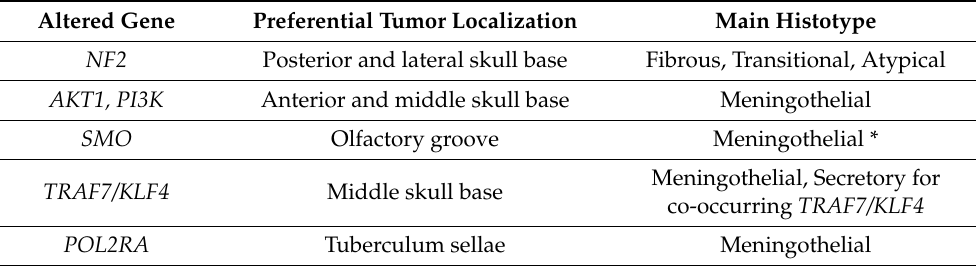
Table 2. Genetic alterations in skull based meningiomas. Altered Gene Preferential Tumor Localization